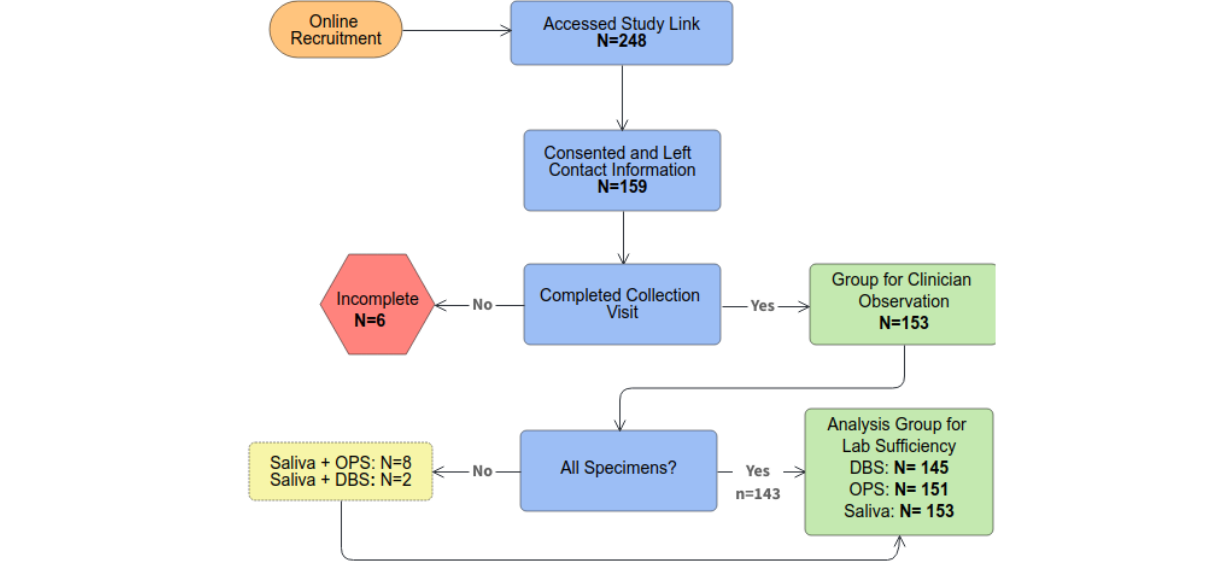
Figure 1. Participant and specimen flow of the iCollect study. DBS: dried blood spot. OPS: oropharyngeal swab.